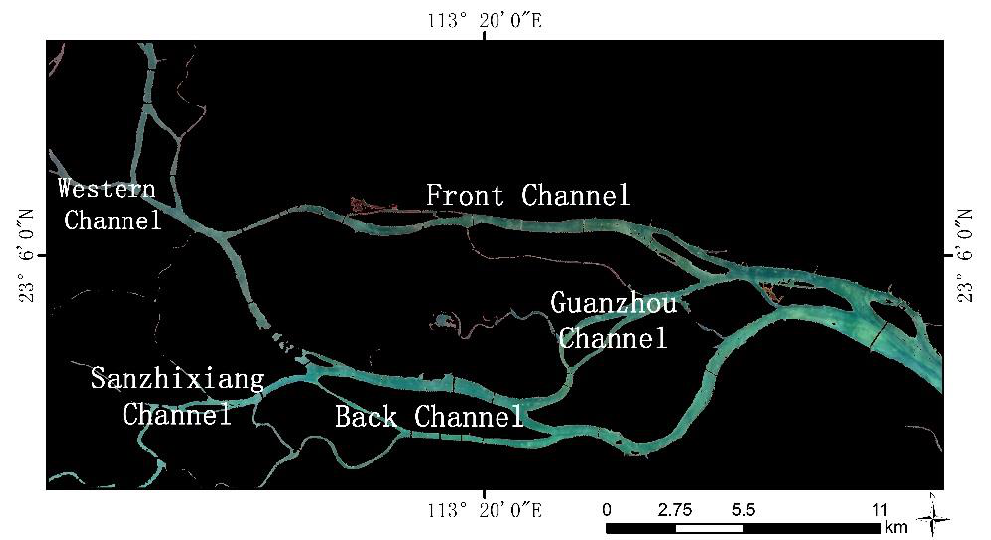
Figure 4. The GF-1 remote sensing data of the Guangzhou Pearl River channels (pseudo-color image).